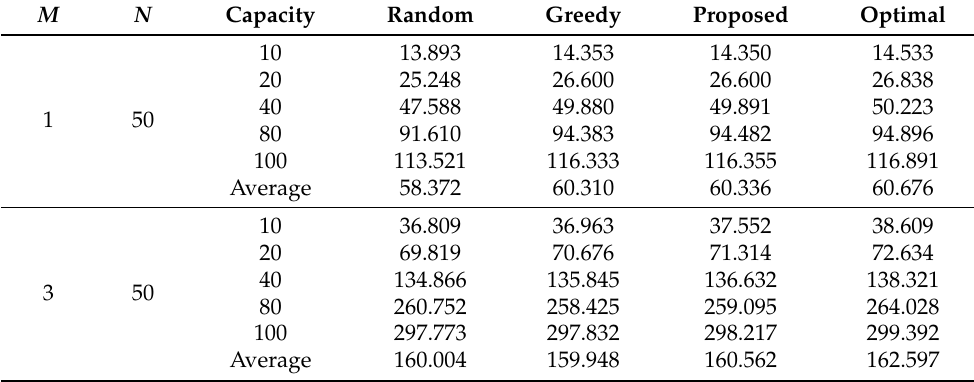
Table 8. Profit of selected items in LI